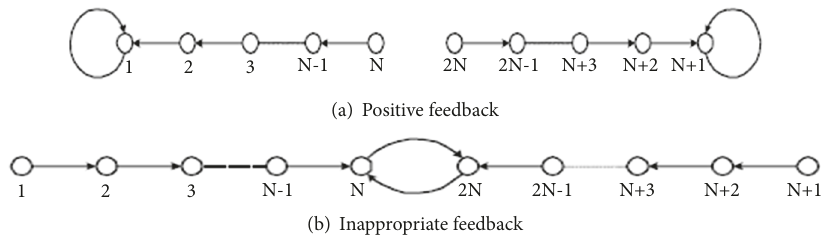
Figure 4: State transition for reward and